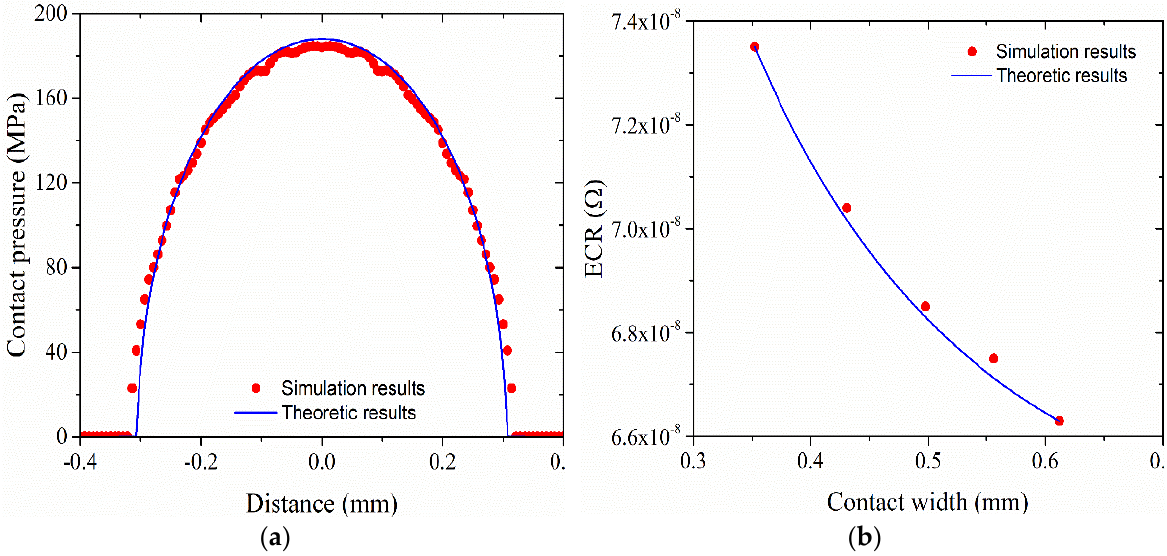
Figure 6. Comparison between the simulation and theoretic results: ( a ) contact pressure distribution and ( b ) ECR. Both results are obtained without the consideration of fretting wear.